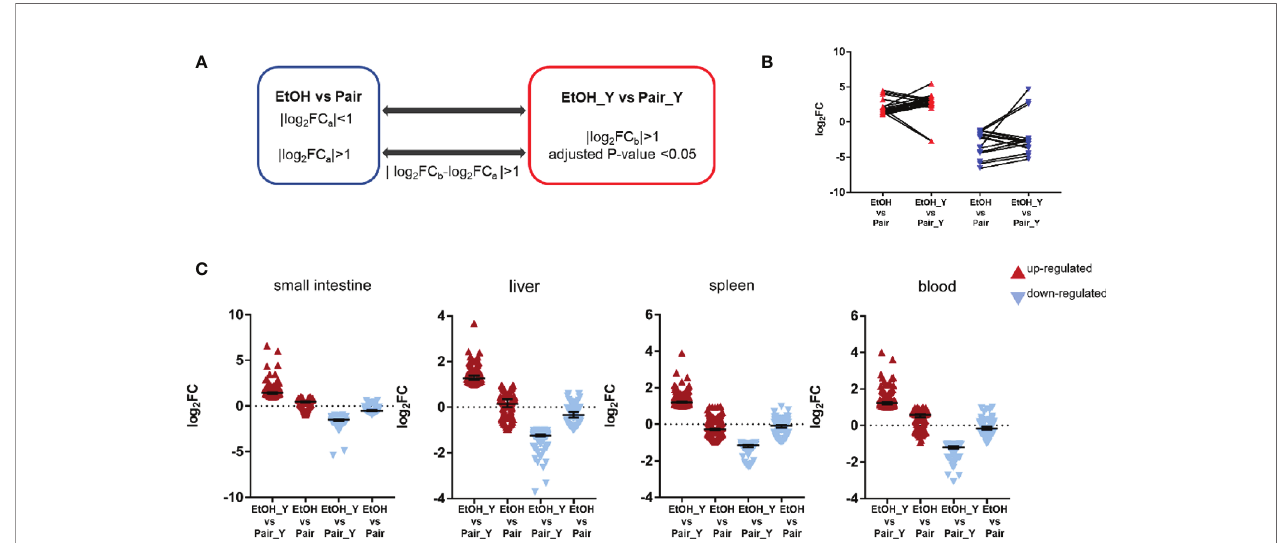
FIGURE 4 | Differential expression analysis between EtOH_Y and Pair_Y. (A) Method for selecting the upregulated and downregulated genes in EtOH_Y compared with Pair_Y. The statistical parameters used as thresholds were: (1) |log 2 FC a | < 1 in control mice and |log 2 FC b | > 1, adjusted P -value < 0.05 in the case of YJ016 infection (2) |log 2 FC a | > 1 in control mice, |log 2 FC b | > 1, adjusted P -value < 0.05 and D values (|log 2 FC b -log 2 FC a |) > 1 in the case of YJ016 infection. (B) The log 2 FC of DEGs selected by method A1. (C) The log 2 FC of DEGs selected by method